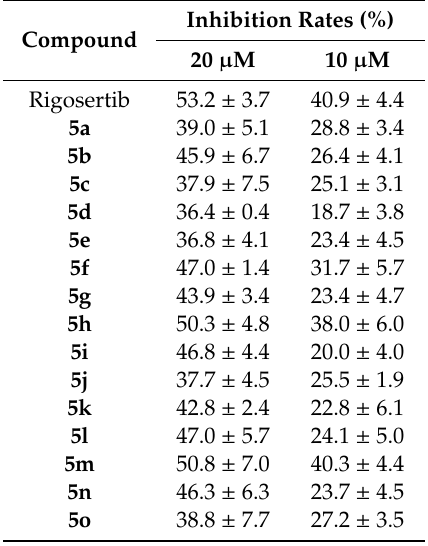
Table 1. The PI3K inhibitory activity of compounds 5a - 5o .